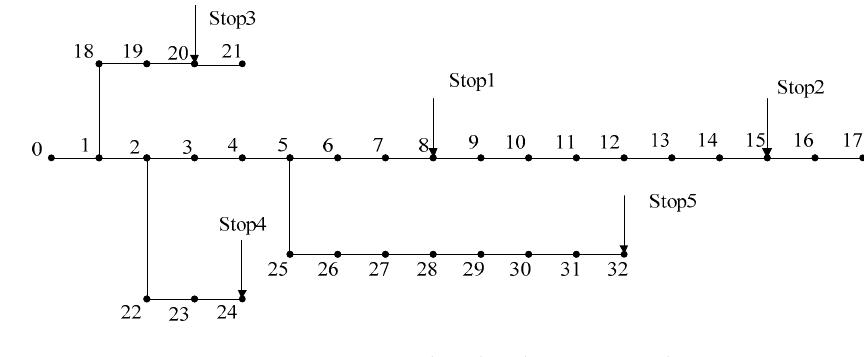
Figure 8. An IEEE 33 ‐ bus distribution network. Table 1. The number of EVs in each EV ‐ station.